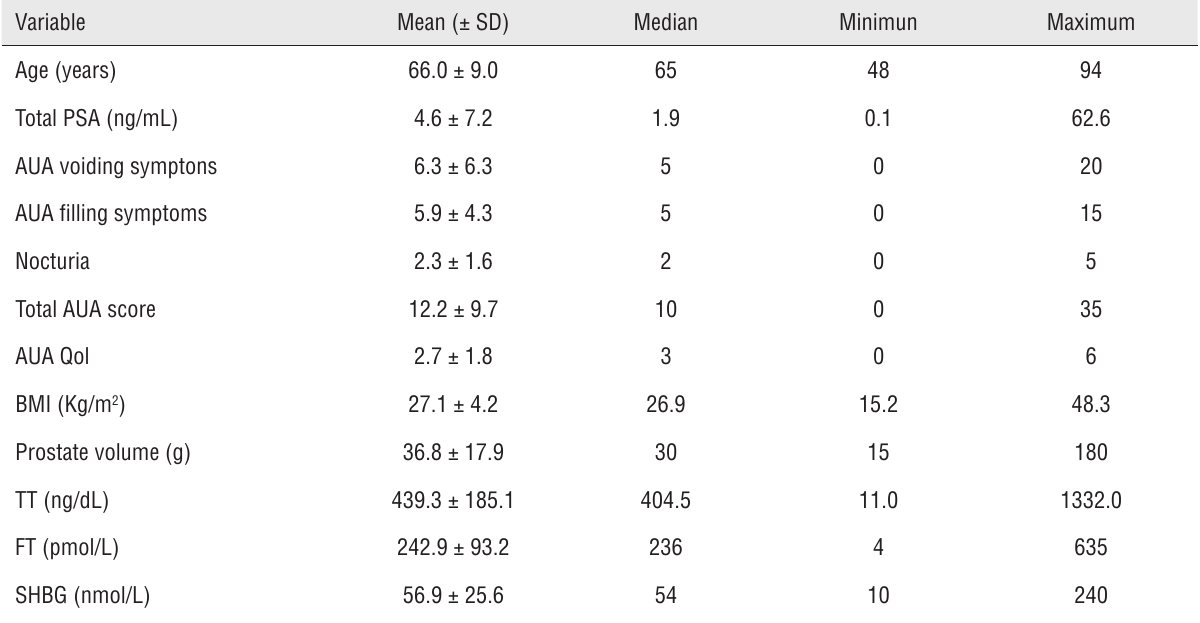
Table 1 - Demographic characteristics of the study population.